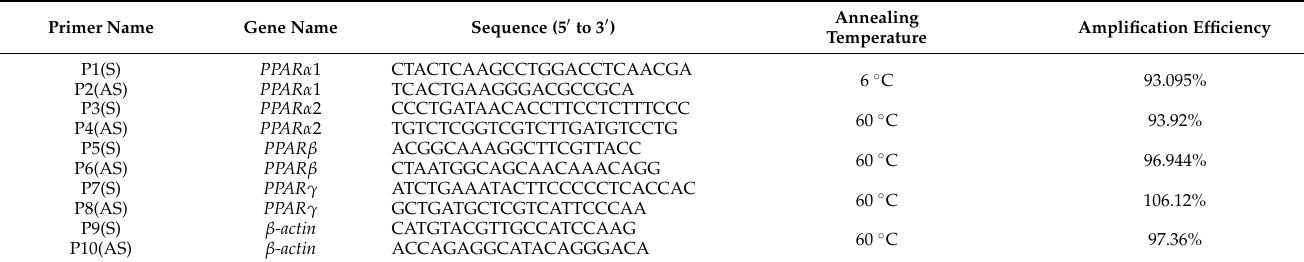
Table 5. Primer sequences used in the